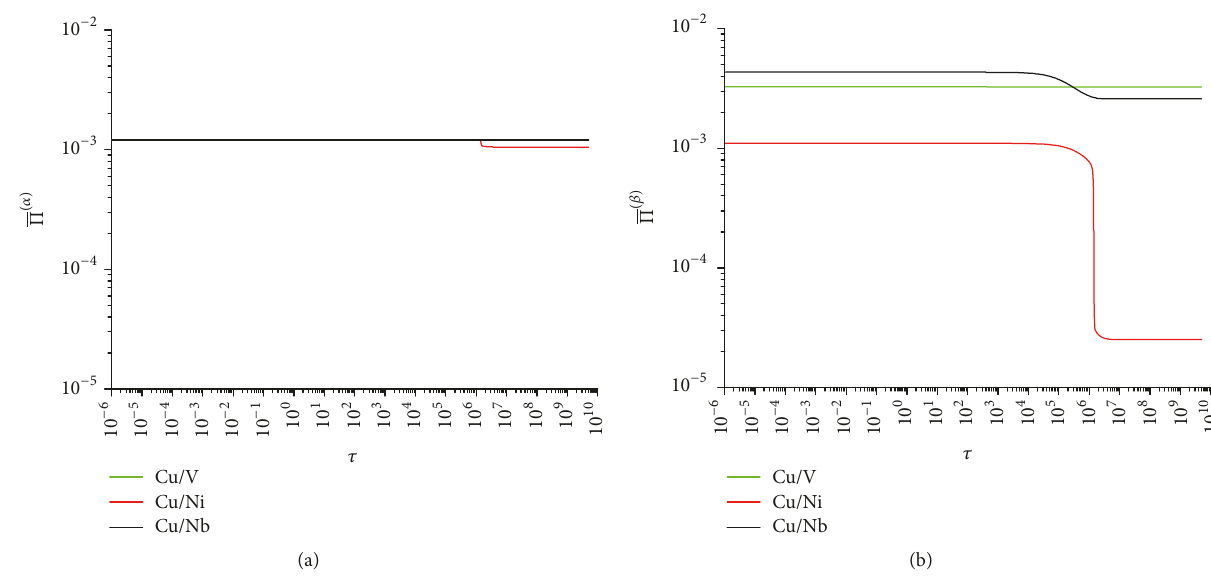
Figure 4: Temporal profiles of average point-defect net-production rate in (a) layer 𝛼 and (b) layer 𝛽 .